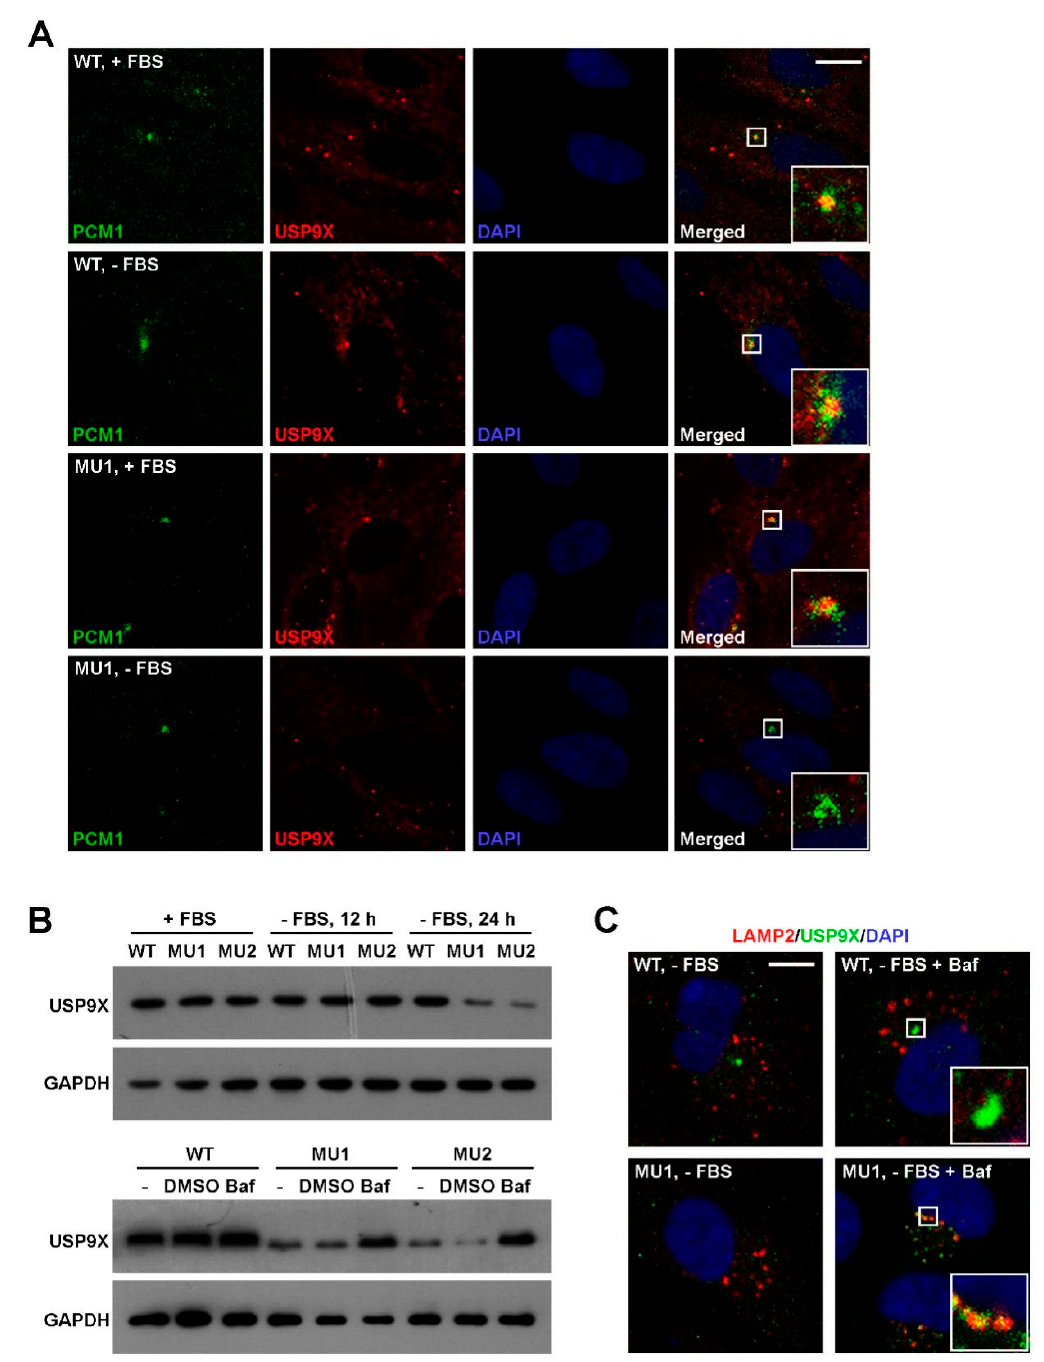
Figure 7. SNX17 is required for homeostasis of USP9X during serum starvation. ( A ) Co-localization of PCM1 and USP9X in WT and SNX17 mutant cells in the presence or absence of serum. ( B ) Enhanced USP9X degradation in SNX17 mutant cells at 24 h after serum starvation determined by western blot. Treatment of cells with Bafilomycin A1 (Baf) was able to rescue the elevated degradation of USP9X in mutant cells. GAPDH was loading control. ( C ) After Baf treatment, USP9X proteins were accumulated in the LAMP2-positive lysosomes in SNX17 mutant cells (15 / 26) but not WT cells (0 / 24). Scale bar in A and C: 10 µm.